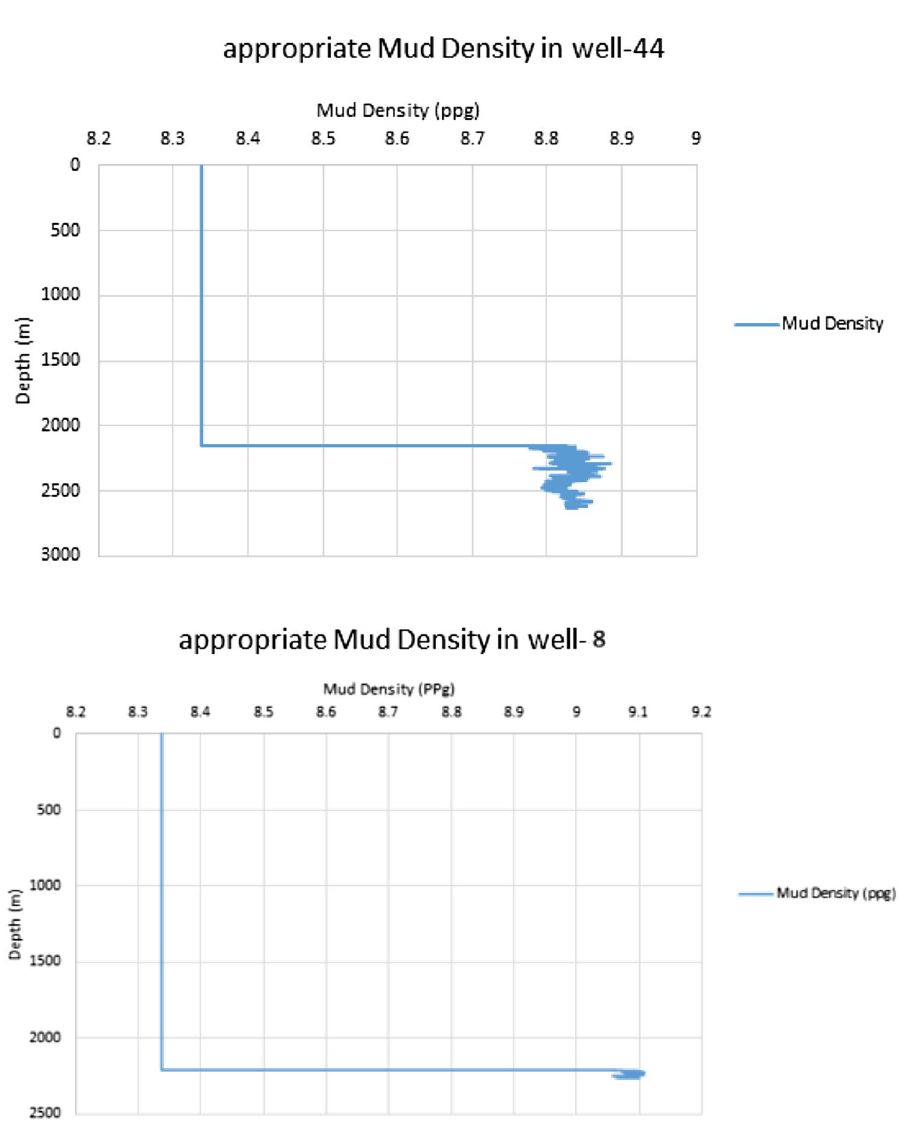
Fig. 10 Suitable density of drilling mud at well no. 44 and well no. 8. In the overpressure interval, the mud density should be increased to 8.8 (ppg) and 9.1 (ppg) in well no. 8 and well no. 44, respectively, in order to avoid the formation